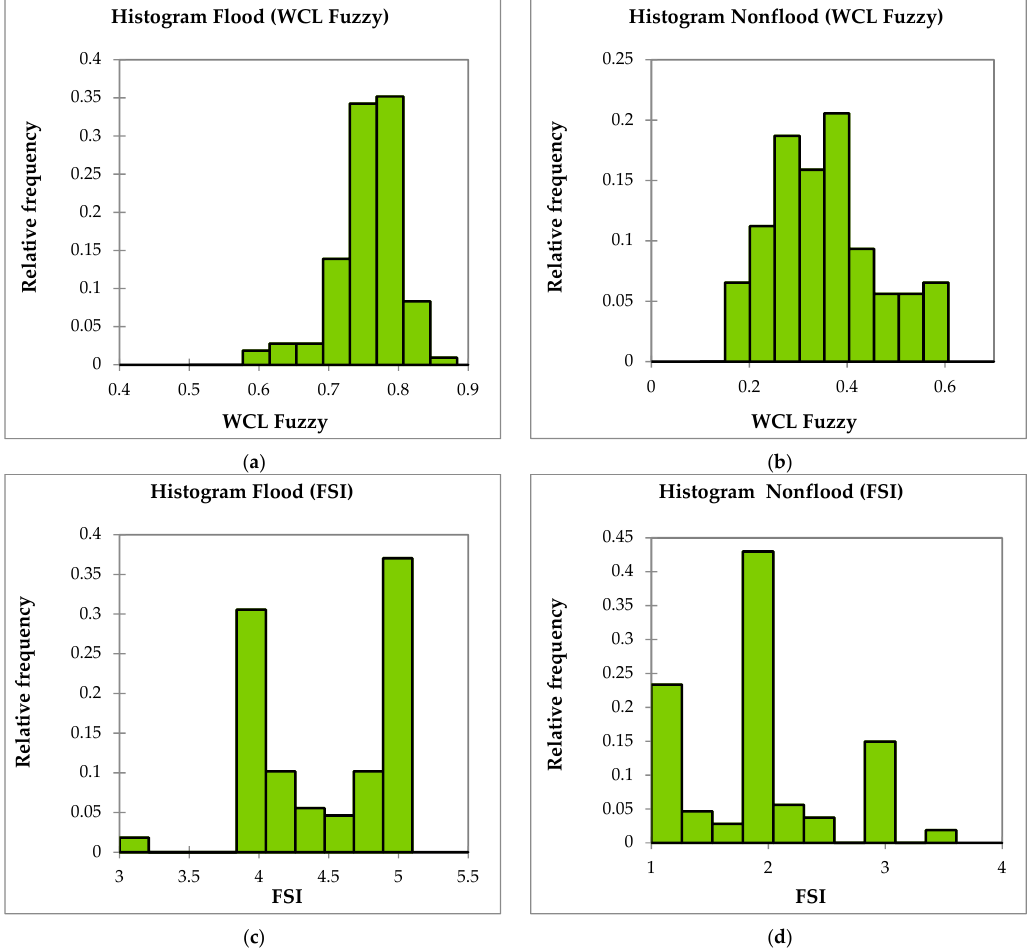
Figure 8. Histograms of the WLC fuzzy ( a , b ) and FSI scales ( c , d ) for flood and non-flood validation